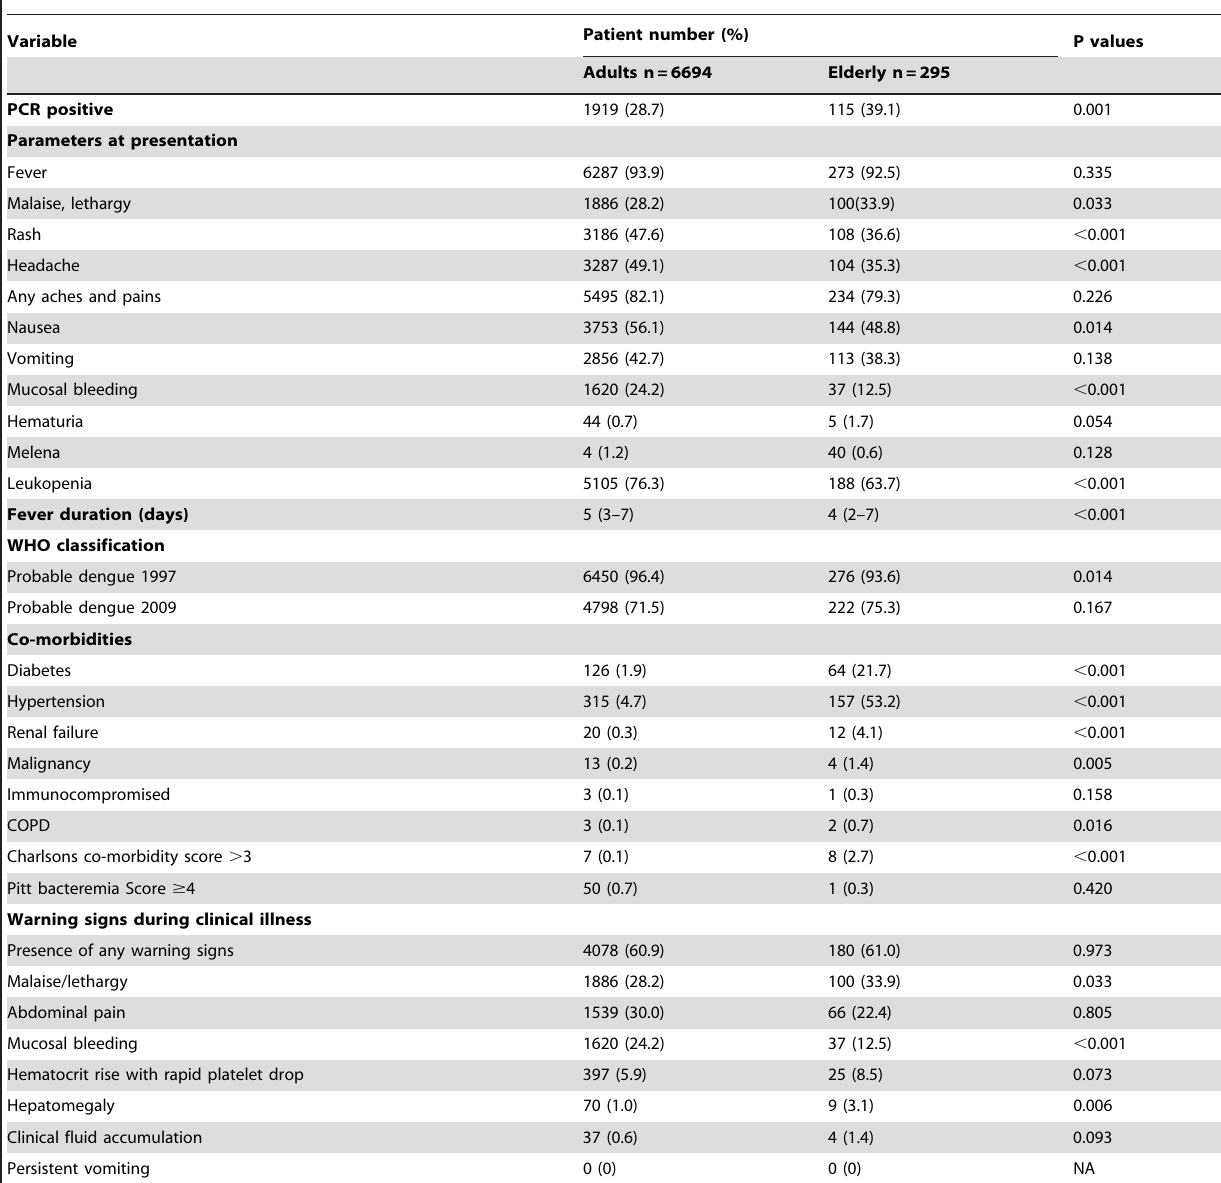
Table 1. Clinical characteristics of elderly patients ( $ 60) and adults ( , 60) with dengue